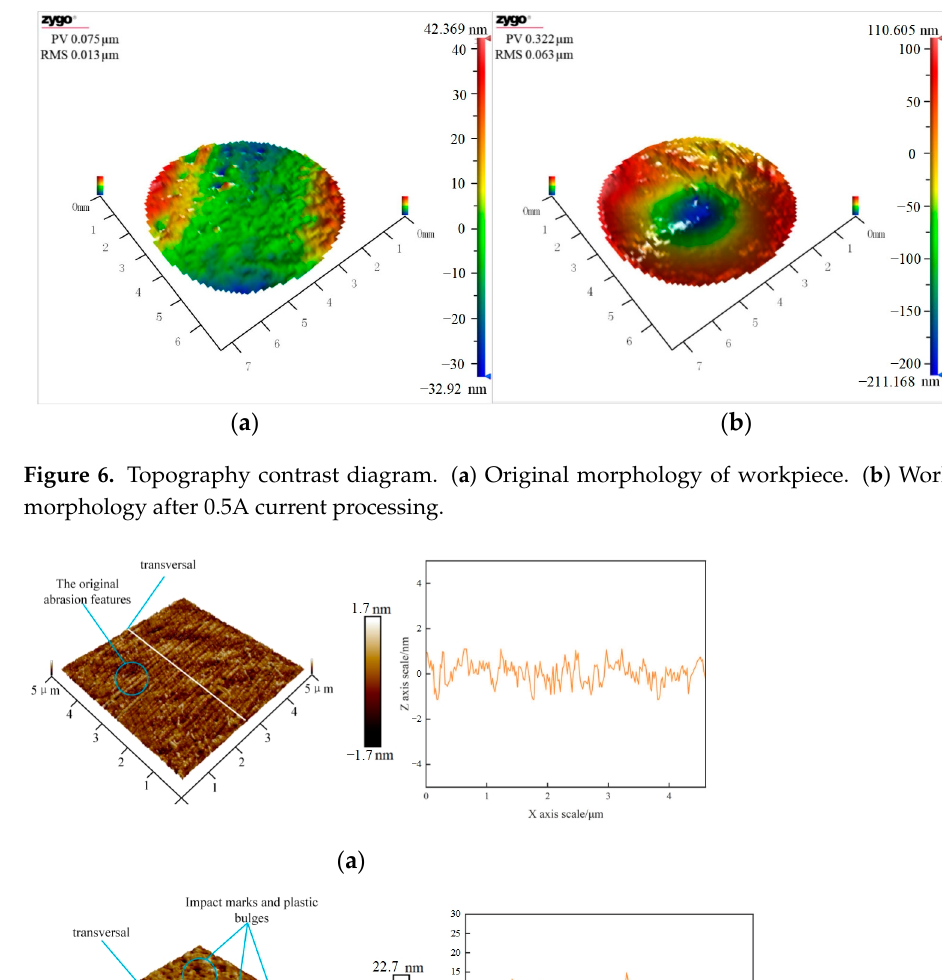
Figure 6. Topography contrast diagram. ( a ) Original morphology of workpiece. ( b ) Workpiece morphology after 0.5A current processing.